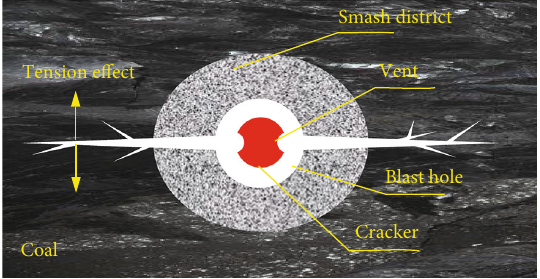
Figure 3: Principle diagram of high-pressure CO